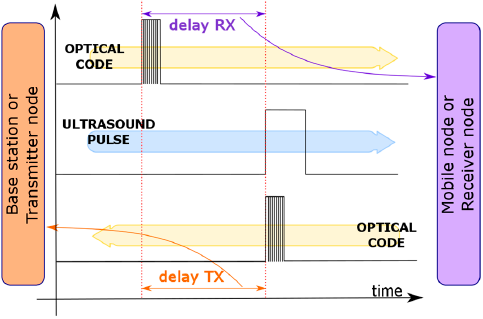
Figure 2. System operational chronogram.